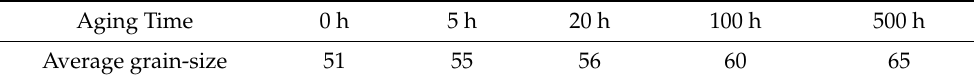
Table 2. The average grain-size of TLP joints after